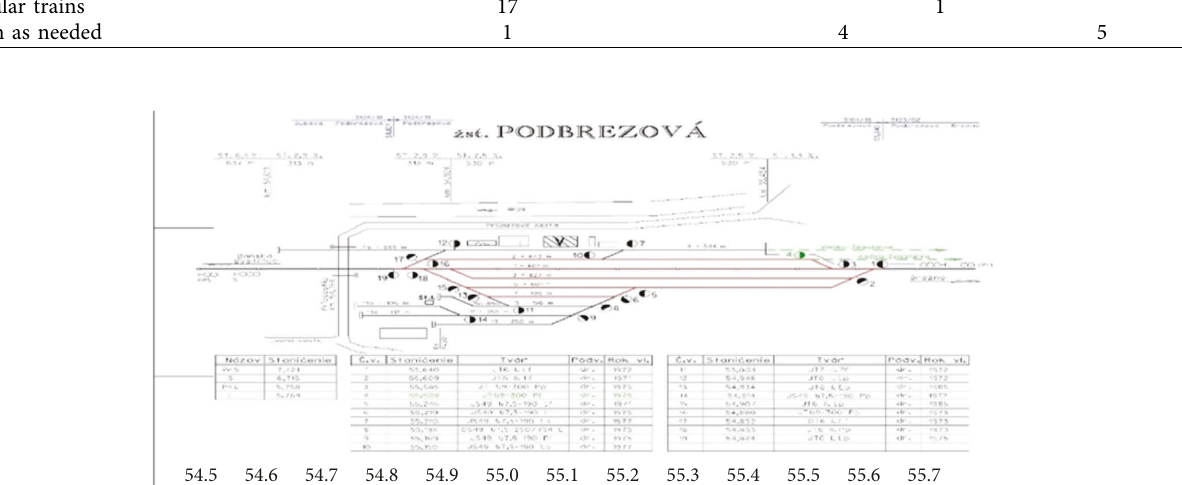
Figure 2: Railway station track plan before its comprehensive reconstruction.